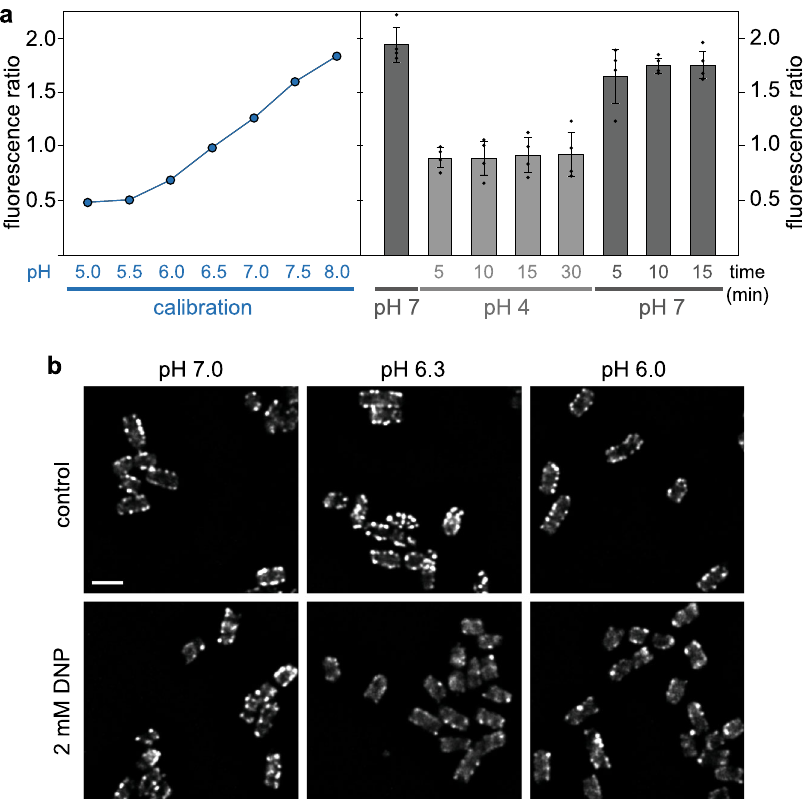
Fig. 3 Low external pH leads to a small drop in cytosolic pH, which does not induce the dissociation of cytosolic T3SS components. a Left, calibration of (Ex 390nm /Ex 475nm ) fl uorescence ratio of puri fi ed pHluorin M153R for the indicated pH values. Technical triplicate, error bars too small to display. Right, determination of cytosolic pH upon changing the external pH from 7 ( fi rst column) to 4 (columns 2 – 5) and back (columns 6 – 8). Fluorescence ratio (Ex 390nm /Ex 475nm ) of bacteria expressing cytosolic pHluorin M153R . n = 4 independent experiments, single data points indicated by small circles. Bars denote mean values, error bars denote standard deviation. b Fluorescence distribution of EGFP-SctQ in live Y. enterocolitica at indicated external pH in absence (top) or presence (bottom) of the ionophore 2,4-dinitrophenol (DNP). The experiment was performed 3 times with comparable results. At pH 4.0, no foci are present. Scale bar, 2 μ